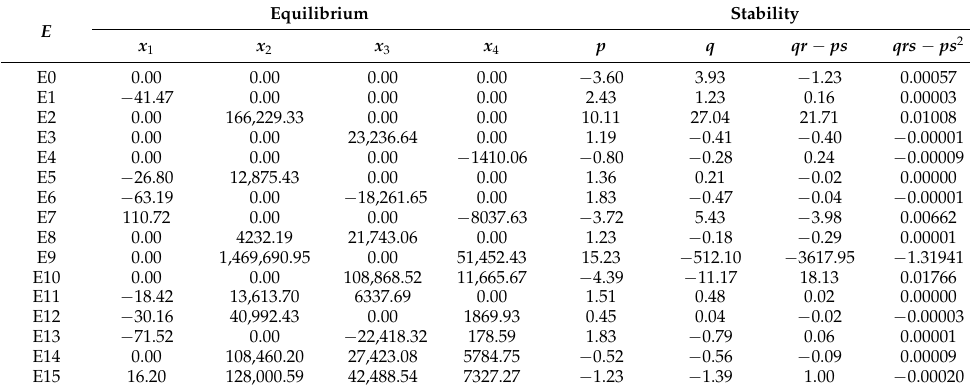
Table 7. Estimated equilibrium and eigenvalues in Tianjin.